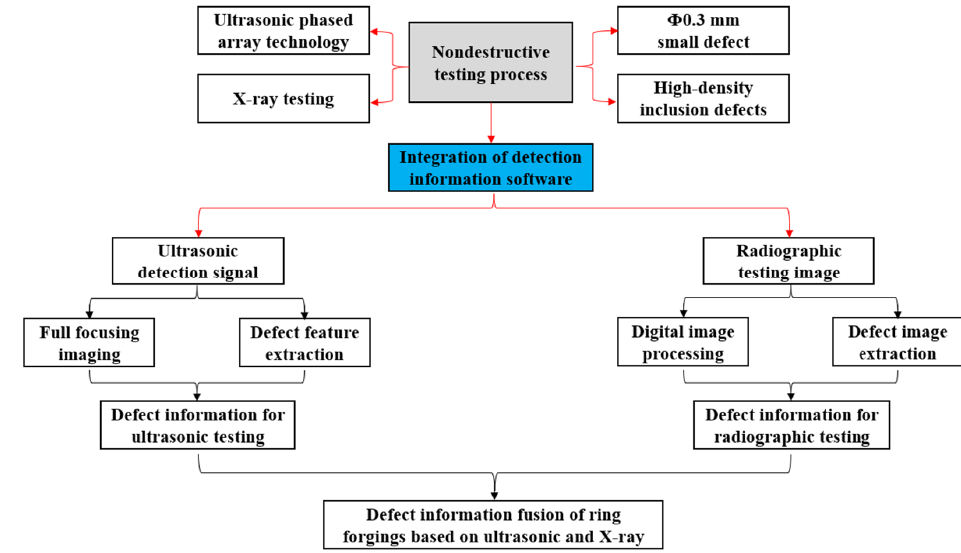
Figure 8. Integrated testing scheme based on ultrasound and X-ray.